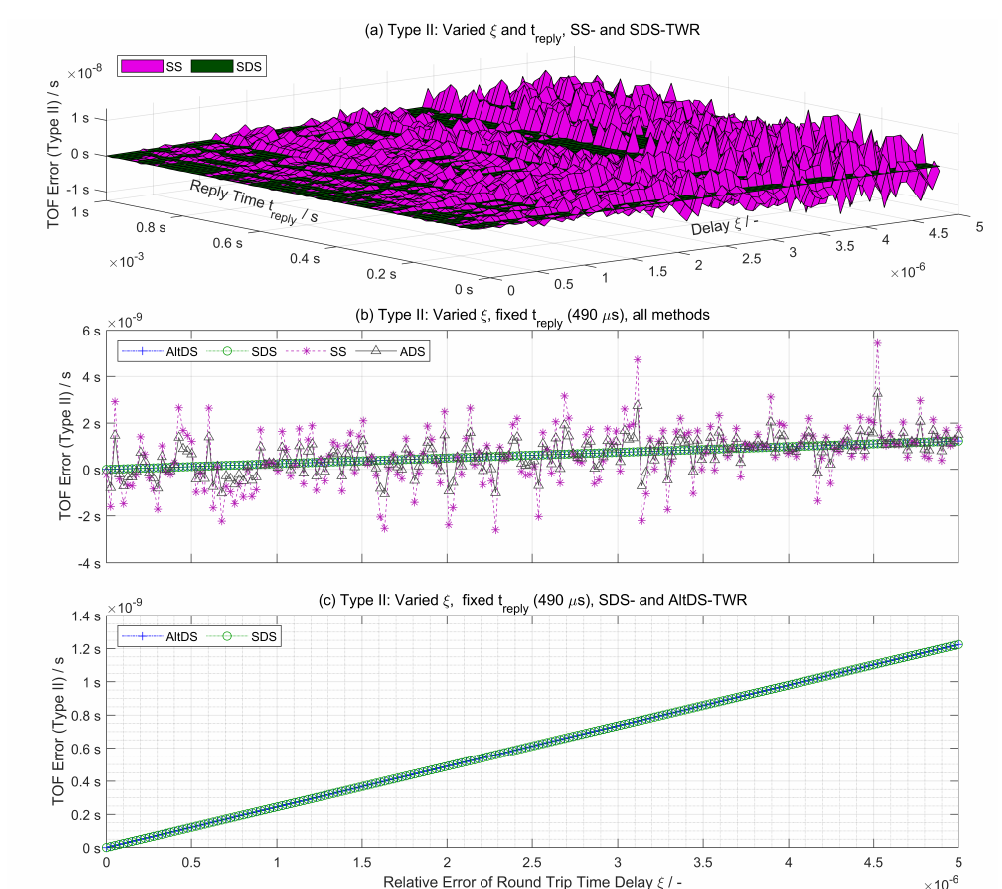
Figure 4. TOF error comparison using a Type II assumption (special case) in accordance with Equations (24)–(27). ( a ) TOF error for SS-TWR and SDS-TWR on 65 sample points (see Table 2); ( b ) TOF error vs. delay ( ξ ); and ( c ) TOF error specifically for SDS-TWR and